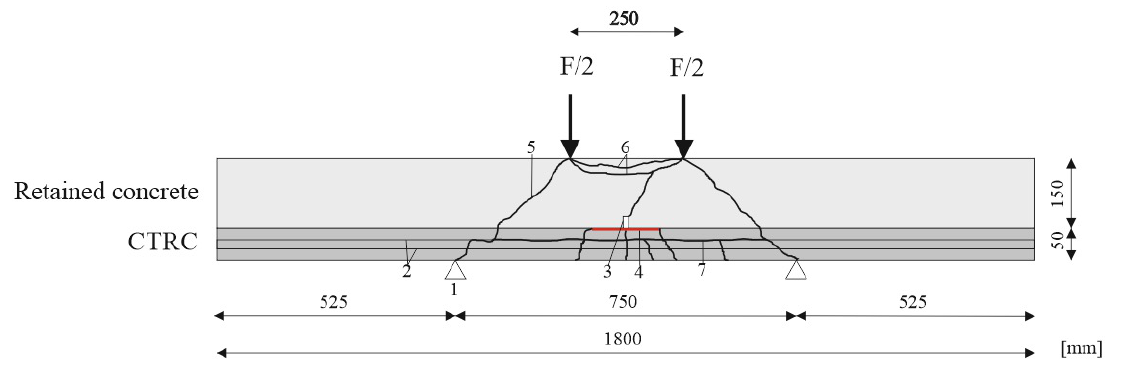
Figure 4. Example of crack pattern. 1: bearings, 2: carbon textile reinforcement layers, 3: joint, 4: bond breaker, 5: shear cracks, 6: horizontal cracks, 7: delamination.